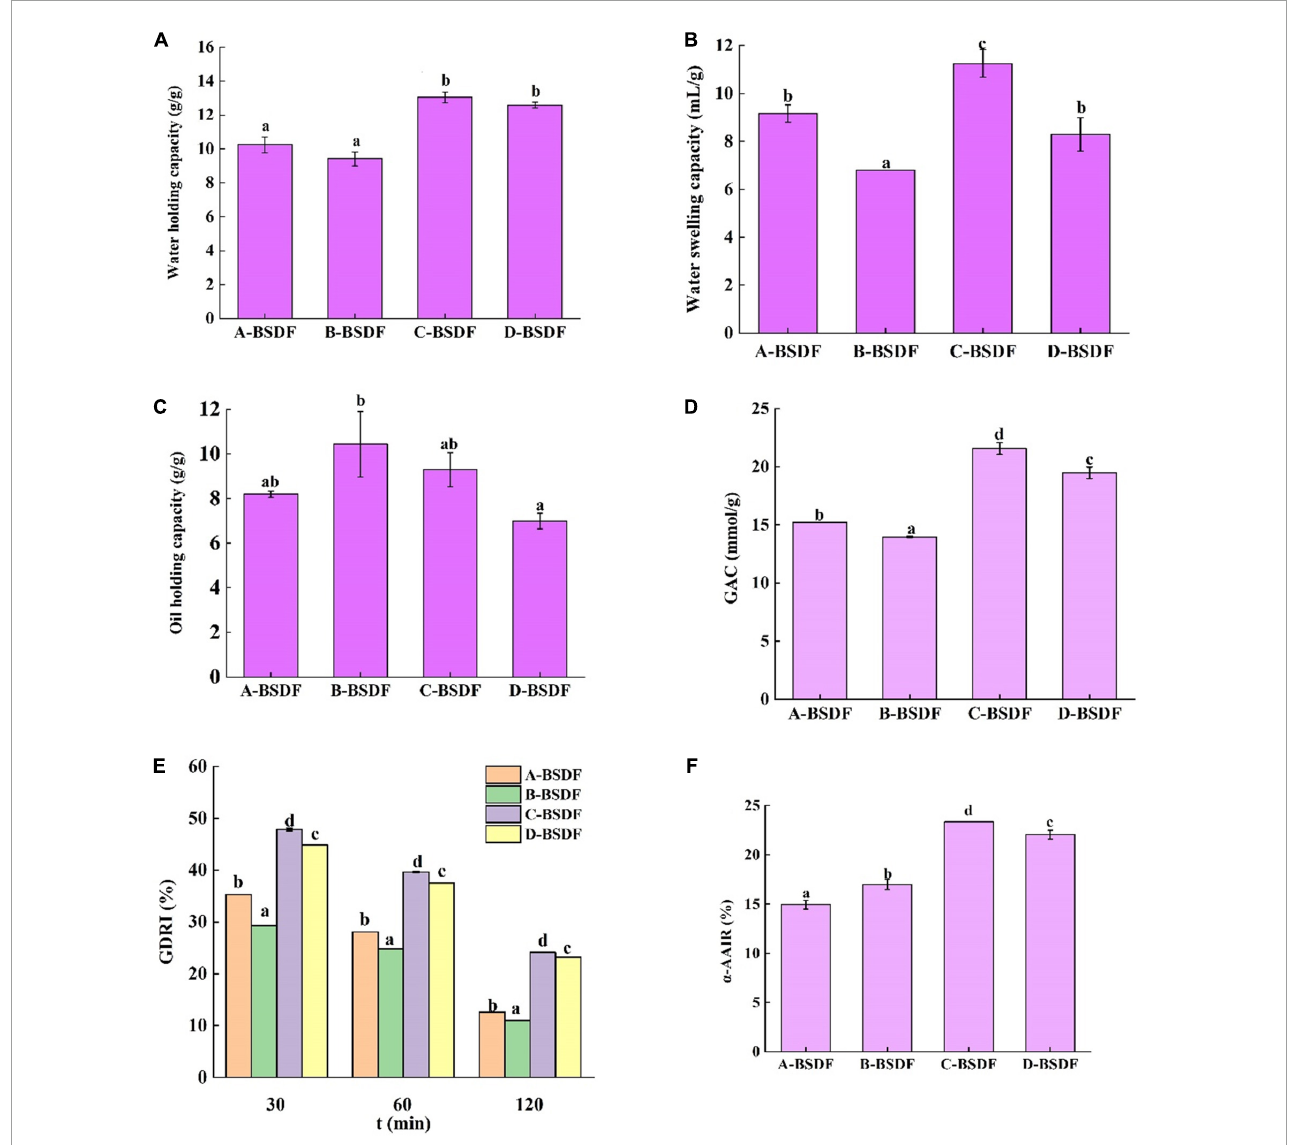
FIGURE5 Water holding capacity of dietary fiber in different bamboo shoots (A) , water swelling capacity of dietary fiber in different bamboo shoots (B) , and oil holding capacity of dietary fiber i n different bamboo shoots (C) , GAC (D) , GDRI (E) , α -AAIR (F) of dietary fiber from different bamboo shoots. Different letters represent significant differences ( p <